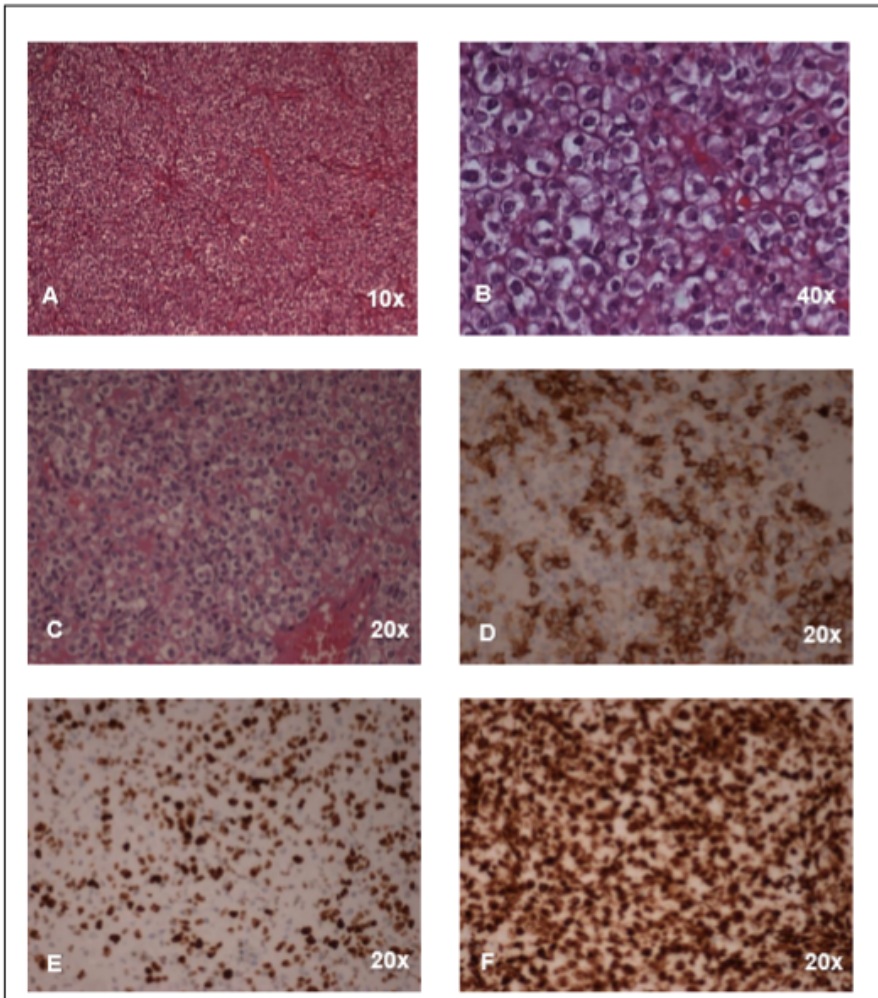
Figure 2. Histology: ( A – C ) Representative images (hematoxylin/eosin staining) of the malignant undifferentiated mesenchymal neoplasia. The cells were mostly epithelioid with clear cytoplasm in a solid pattern. ( D – F ) Immunostaining for CD99 ( D ), Ki67 (E), and WT1 ( F ).